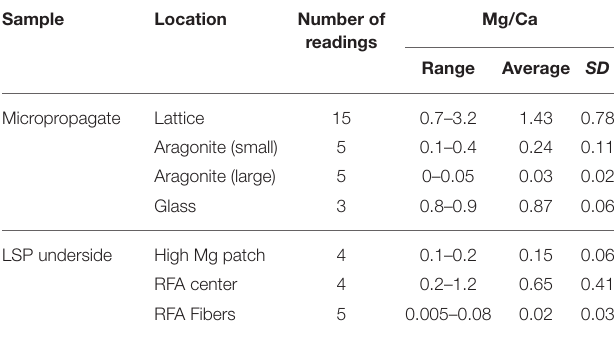
TABLE 1 | Mg/Ca ratios at different sites examined during this study.